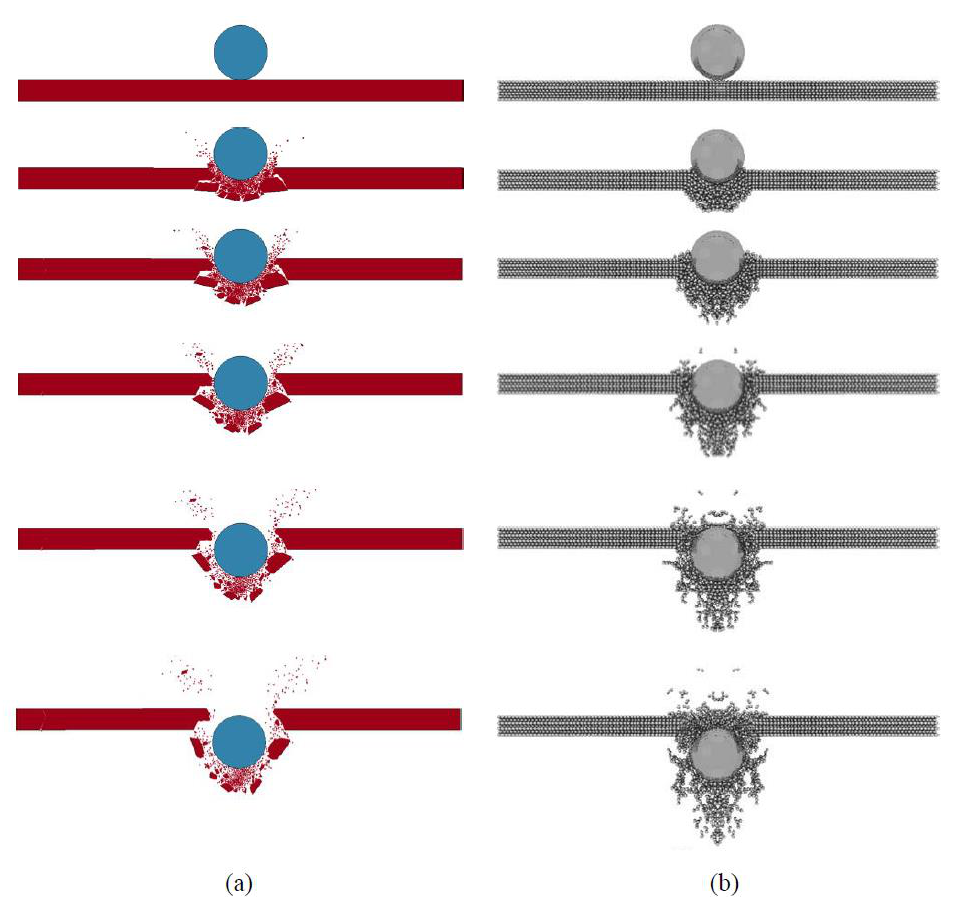
Figure 4. Failure sequences at t = 0, 0.1, 0.2, 0.3, 0.4, 0.5 ms: ( a ) FDEM; ( b ) DEM (Adapted from Ref.